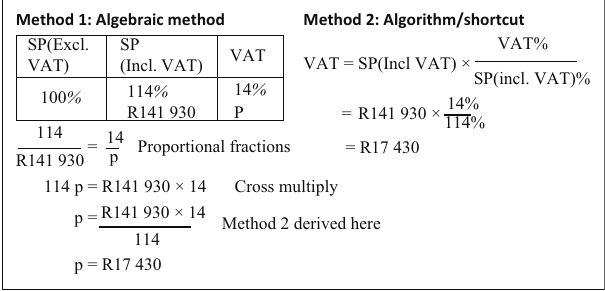
FIGURE 18: Value-added tax calculation.